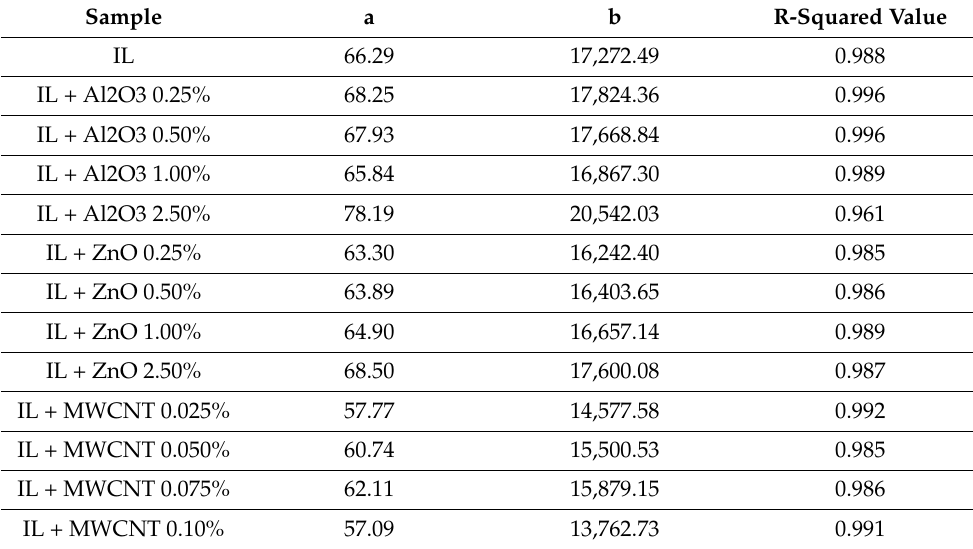
Table 4. Correlation coefficients for each sample according to Equation